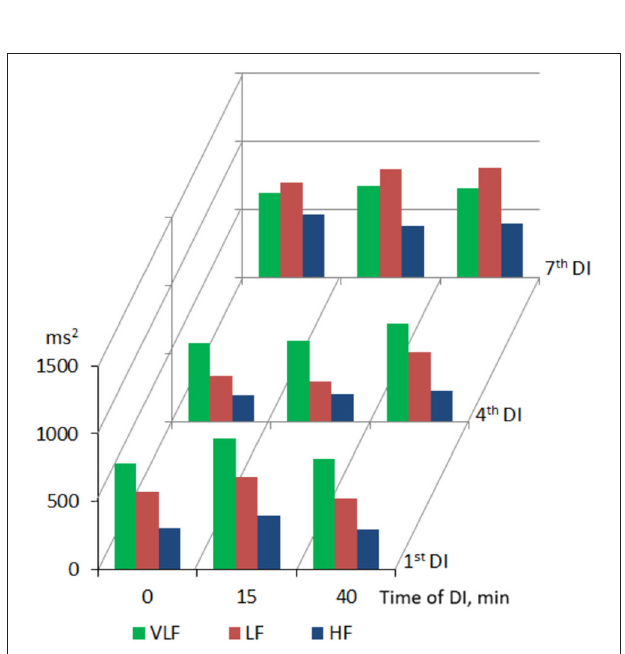
FIGURE 3 | Frequency-domain HRV parameters in PD patients during repeated “”dry” immersion sessions.